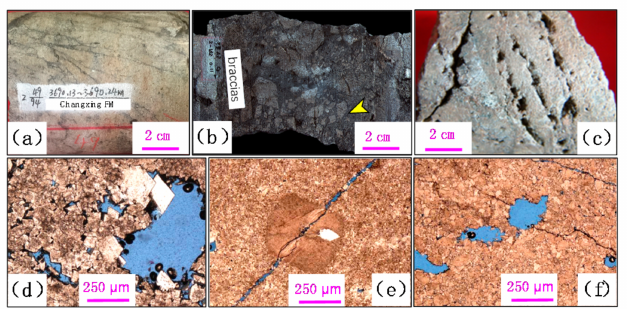
Figure 4. Photographs of the Permian carbonate reservoirs. ( a ) high dip fracture network, T110, 3690 m, core; ( b ) breccias in the fault damage zone, Q42, 4901 m, core; ( c ) dissolution pores and vugs along fractures, F3, 4884 m, core; ( d ) intercrystalline dissolution pores in the dolomite, T110, 4337.12 m, thin section; ( e ) opened fracture across the bioclastic dolomite, F3, 4884.07 m, thin section; ( f ) oblique fractures and dissolution pores, T2, 3859.60 m, thin section.